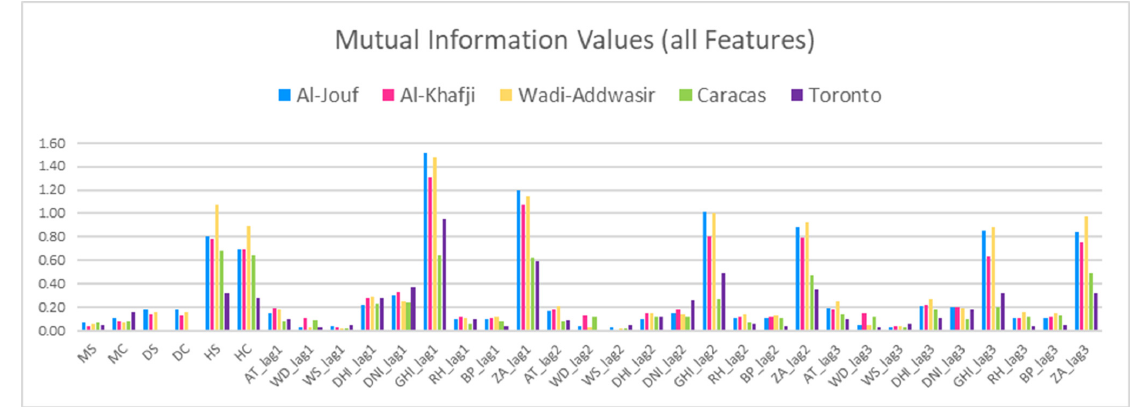
Figure 15. MI values of all features for Al-Jouf, Al-Khafji, Wadi-Addwasir, Caracas, and Toronto datasets.